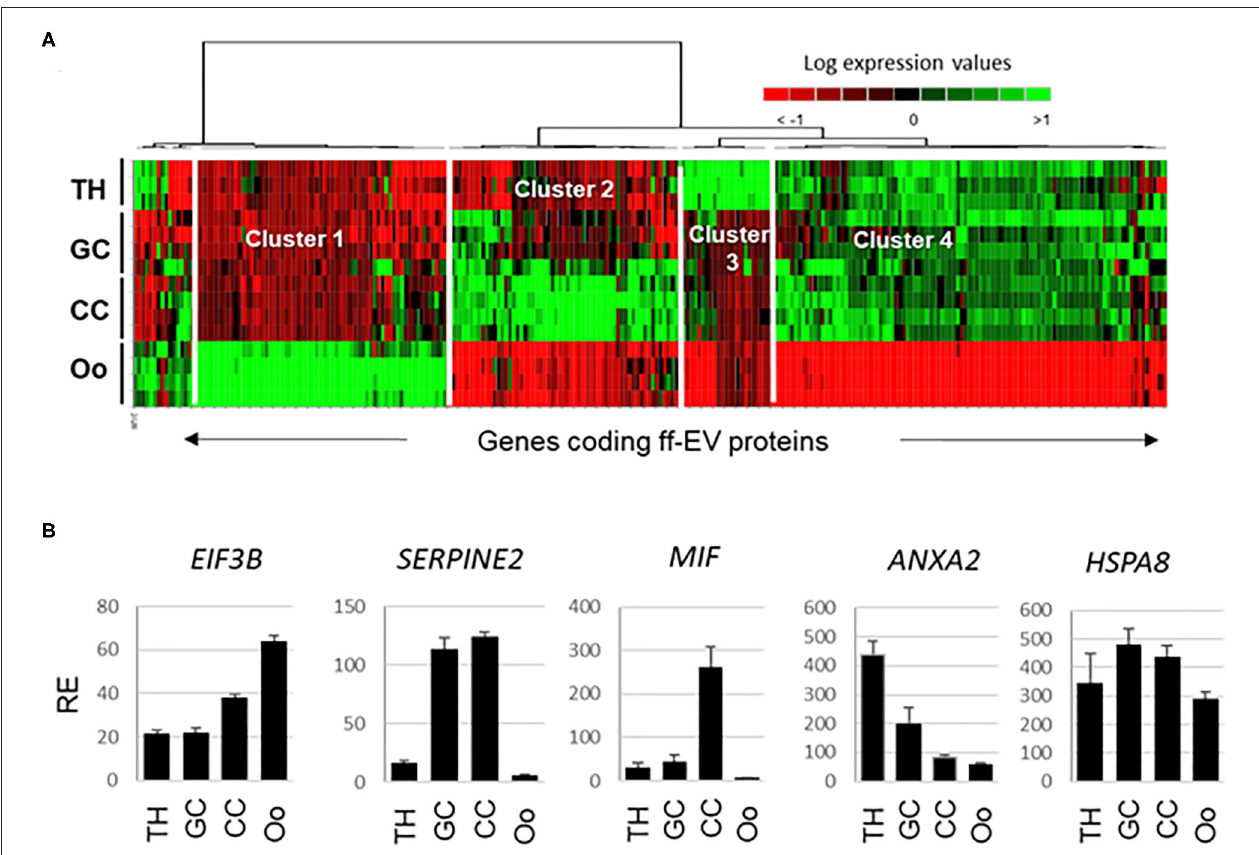
FIGURE 6 | Integrative transcriptomic analysis of genes encoding proteins identified from ffEVs that were determined to be differentially expressed in different bovine follicular cell types including theca cells (THs), granulosa cells (GC), cumulus cells (CC), and oocytes (OOs). (A) Heat map representation of genes encoding proteins identified in ffEVs. (B) Examples of genes from each cluster of the heatmap are